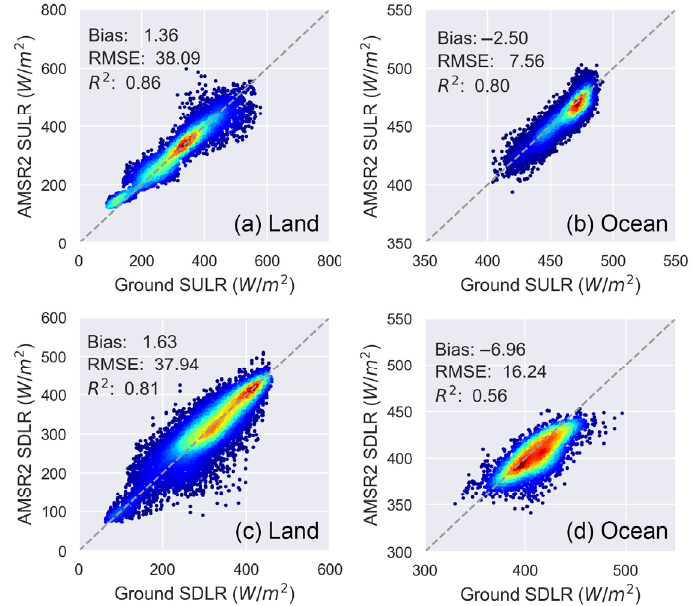
Figure 11. Validation of the 10-km Advanced Microwave Scanning Radiometer 2 (AMSR2) surface longwave radiation using site measurements. ( a ) AMSR2 surface upward longwave radiation (SULR) based on Baseline Surface Radiation Network (BSRN) data; ( b ) AMSR2 SULR based on Global Tropical Moored Buoy Array (GTMBA) data; ( c ) AMSR2 surface downward longwave radiation (SDLR) based on BSRN data; and ( d ) AMSR2 SDLR based on GTMBA data. The color indicates the density of sampling points, with higher density in red and lower density in blue.